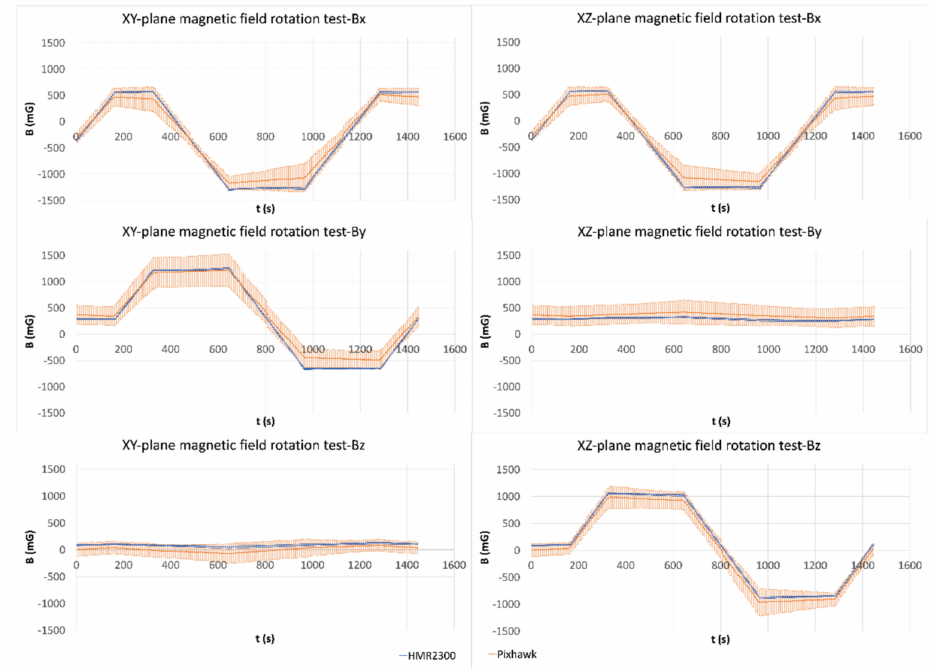
Figure 6. Left : Magnetic field rotation test around z -axis for X , Y and Z directions, showing mean value (solid lines) and error bars (vertical segments) for standard gaussmeter (blue) and for Pixhawk (orange). B represents magnetic field, with Bx being the x -axis magnetic field, By the y -axis magnetic field and Bz the z -axis magnetic field; t represents time. Right : Magnetic field rotation test around y - axis for X , Y and Z directions, showing mean value (solid lines) and error bars (vertical segments) for standard gaussmeter (blue) and for Pixhawk (orange). B represents magnetic field, with Bx being the x -axis magnetic field, By the y -axis magnetic field and Bz the z -axis magnetic field; t represents